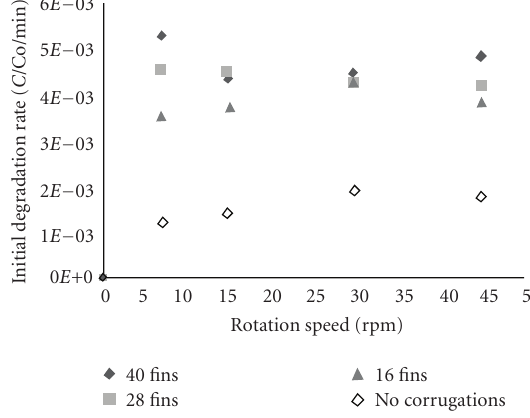
Figure 7: E ff ect of varying rotational speed on initial degradation rate for finned